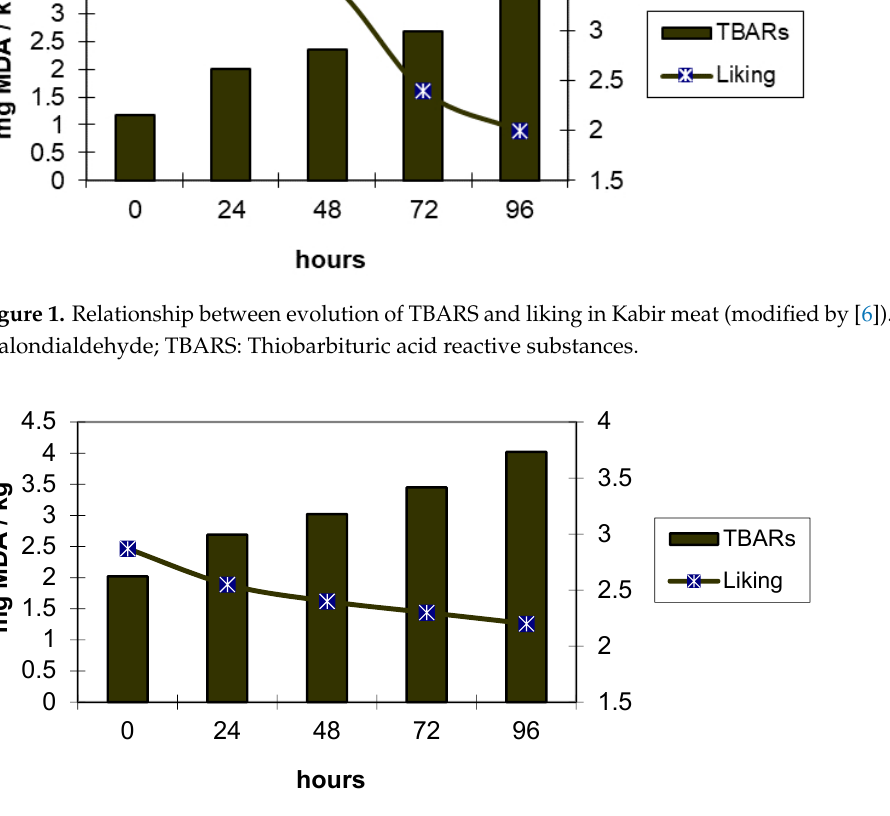
Figure 2. Relationship between evolution of TBARS and liking in Ross 308 meat (modified by [6]). MDA: Malondialdehyde; TBARS: Thiobarbituric acid reactive substances.